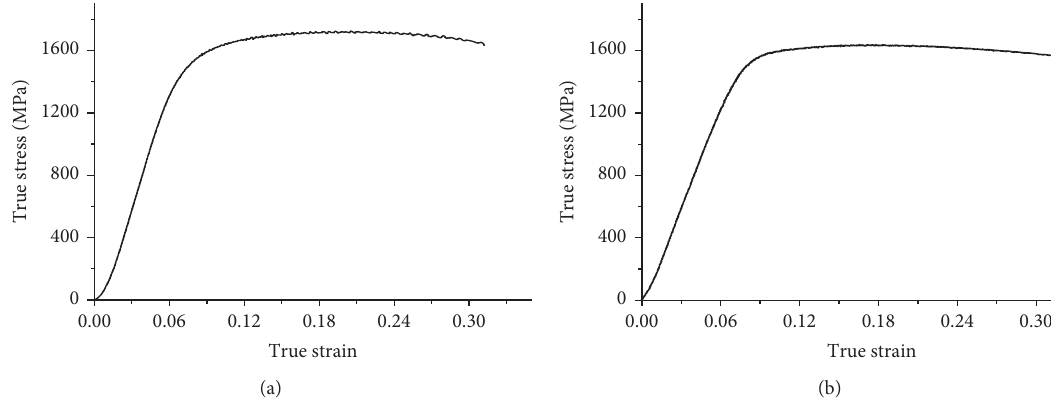
Figure 11: Quasi-static compressive stress-strain curve. (a) QP980 steel RSW; (b) TRIP800 steel RSW. Table 3: Experimental conditions of the dynamic compression of QP980 steel spot welds at room temperature. Temperature ( ° C) Height of specimen (mm) Diameter of specimen (mm) Test 1